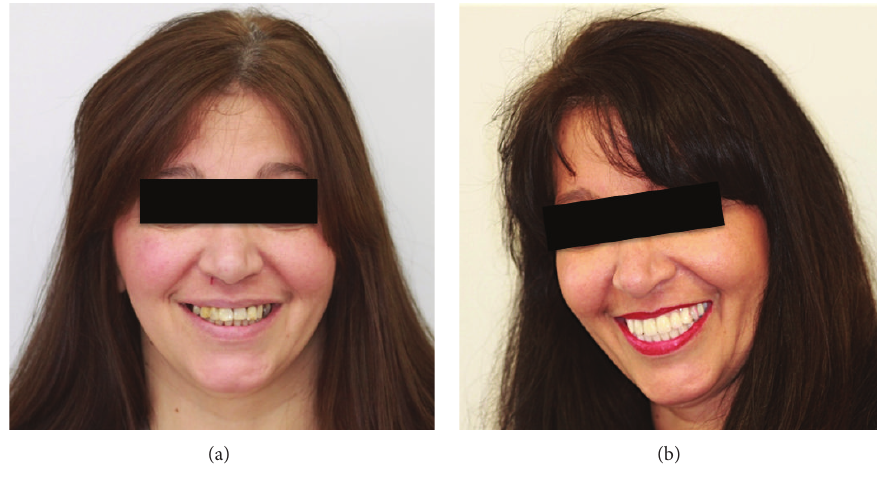
Figure 12: Frontal views for patient’s smile. (a) Pre-treatment. (b) During